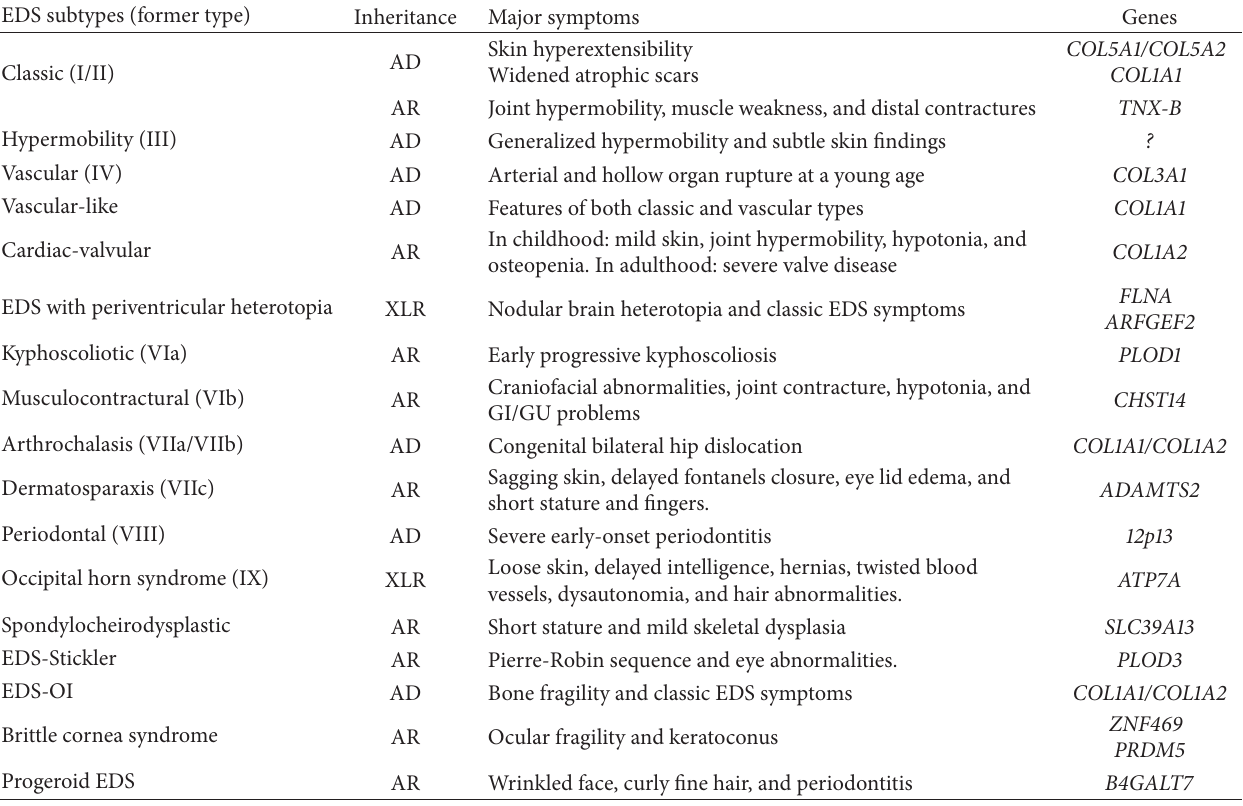
Table 1: Overview of Ehlers-Danlos syndromes (adapted from De Paepe and Malfait